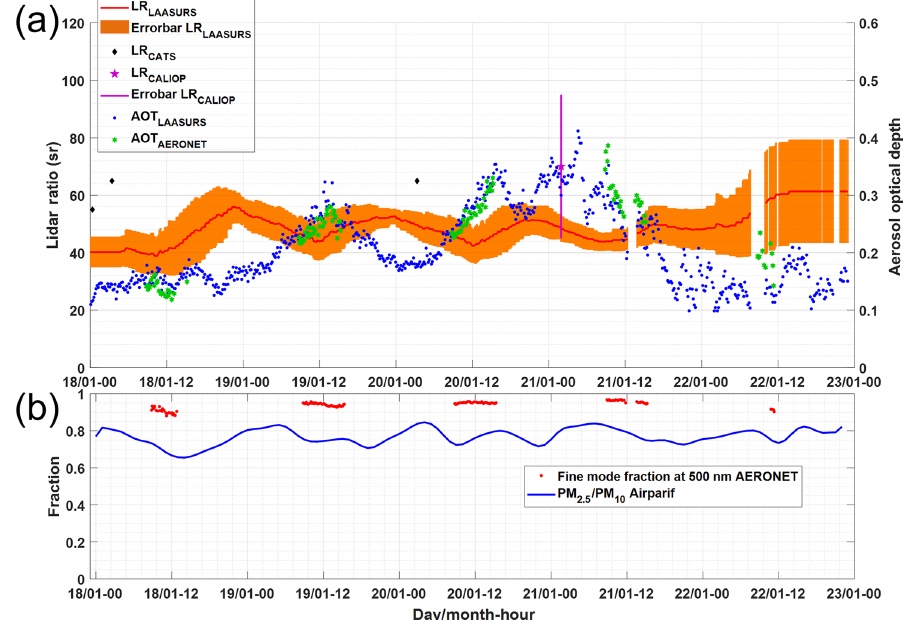
Figure 8. Same as Fig. 7 but for the January 2017 pollution